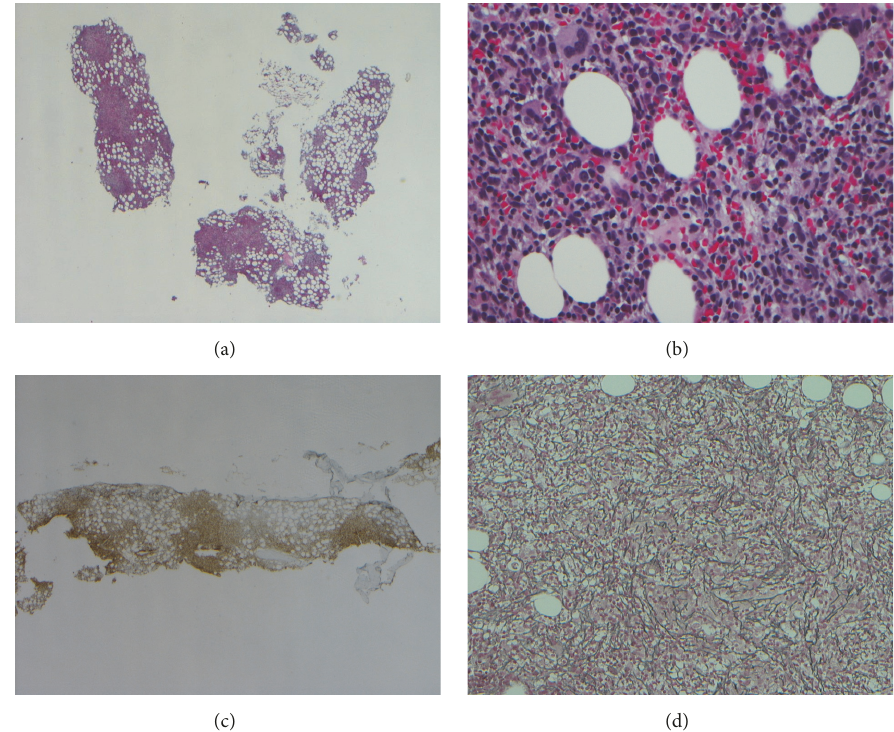
Figure 1: The bone marrow biopsy showed a nodular proliferation of T cells ((a) H&E, 20x; (b) H&E, 400x; (c) CD3, 20x) and increased reticulin fibrosis ((d) reticulin stain,